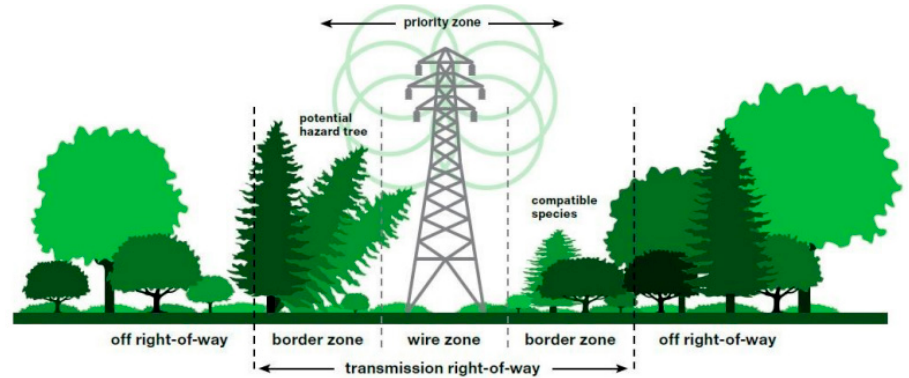
Figure 6. Schematic representation of the protection zone [25].